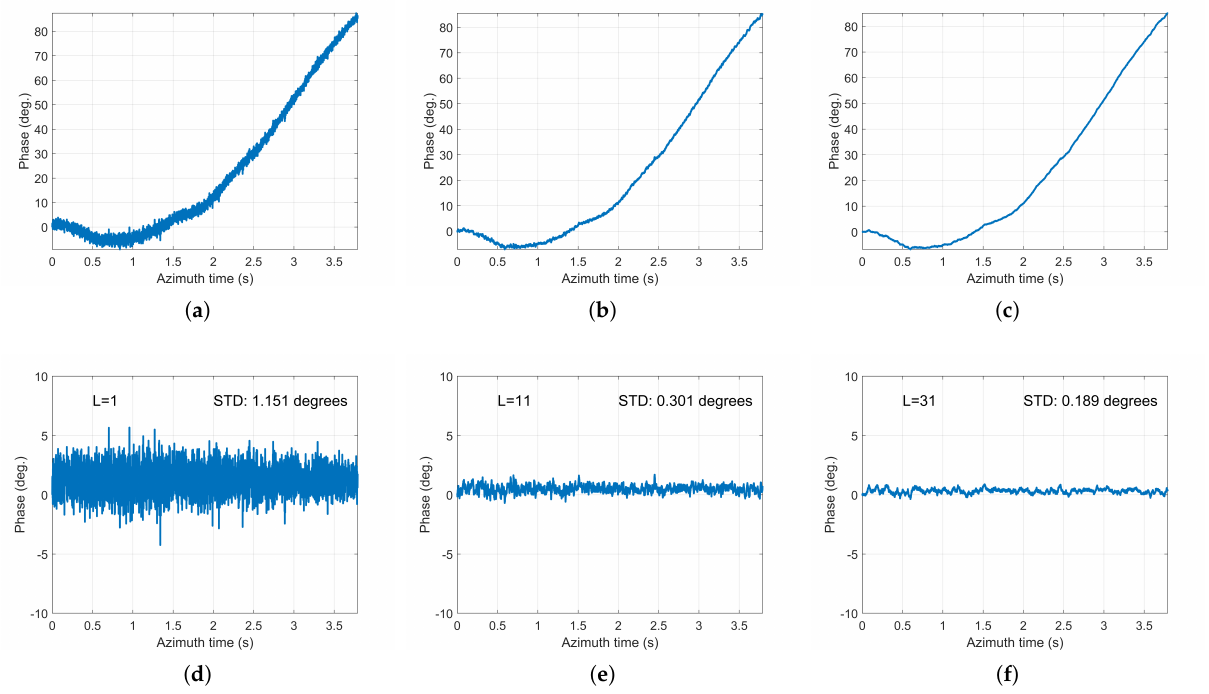
Figure 16. ( a – c ) The estimated synchronization phase. ( d – f ) The residual phase after compensation. ( a , d ) L = 1; ( b , e ) L = 11; ( c , f ) L =